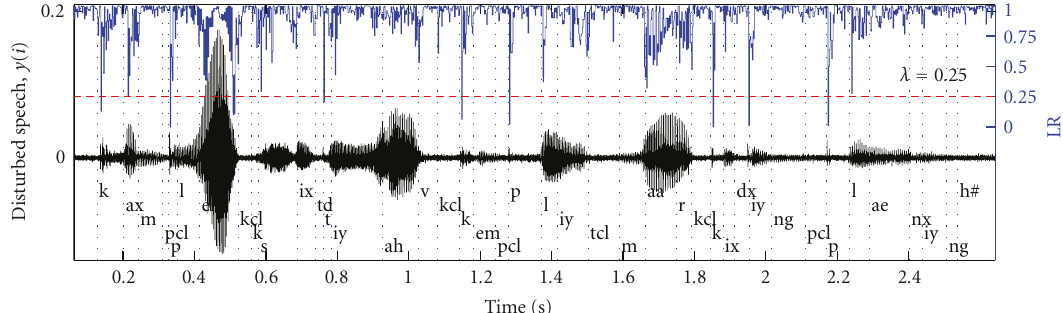
Figure 11: Example usage of the detector for low-delay detection of instationarities in continuously spoken disturbed speech (bottom, “complexity of complete marketing planning”, [21]). The LR values are plotted on top, the decision threshold λ = 0 . 25 is represented by the dash-dotted line.